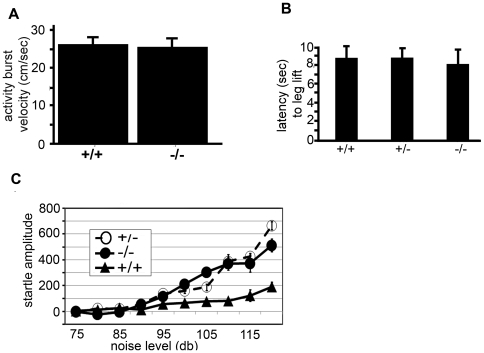
Unconditional, startle and hot plate responses are similar in knockout and wild type mice.A) No difference in activity burst velocity during the 2 sec following electric shock of wild type (n = 22) and Atxn2 ko (n = 16) mice in cohort A. Activity burst velocity was determined as described in Anagnostaras et al, 2000 (19). B) Hot plate latency of wild type (n = 7), Atxn2 heterozygous (n = 9) and Atxn2 ko mice (n = 9) in cohort B. Reaction to pain on the hot-plate was similar for the three genotypes. C) Startle responses to increasing sound levels of wild type (n = 9), heterozygous (n = 9), and Atxn2 ko (n = 7) mice. Startle was increased in heterozygous and Atxn2 ko mice starting at sound levels >95 db (one-way ANOVA, p = 0.01).